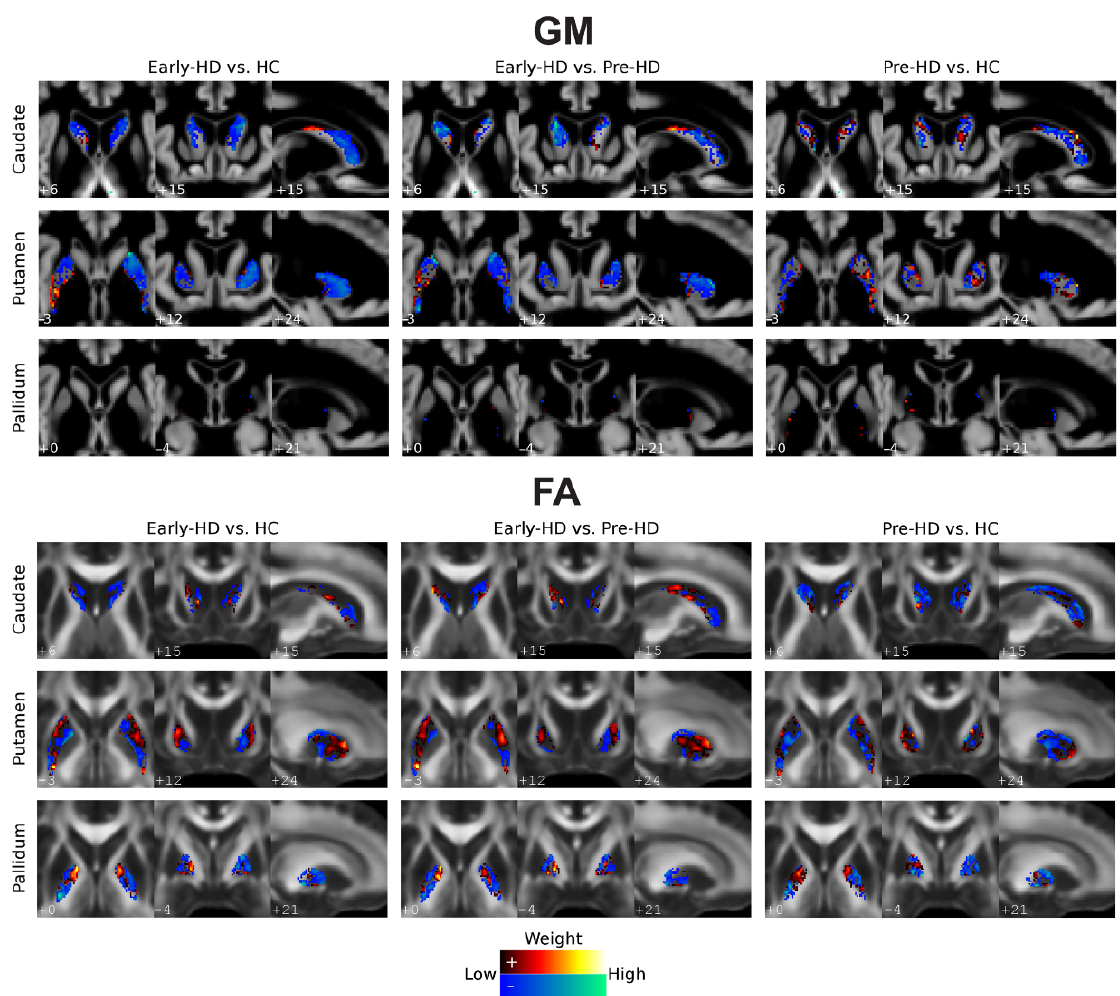
Figure 2. Voxels’ weight maps for binary classifications using subcortical ROIs. Weight maps are depicted for each binary classification (Early-HD vs. Pre-HD, Early-HD vs. HC, and Pre-HD vs. HC) and subcortical ROI (bilateral caudate, putamen, and pallidum, respectively). Axial, coronal, and sagittal views that maximize visualization of each ROI per one slice, respectively, are identified. Top: Classification with GM features. The weight maps are overlaid on a mean GM image, in grey scale, calculated using all study participants; Bottom: Classification with FA features. For visualization, the weights are overlaid on a standard FA image (FMRIB58_FA) to which each participant’s data were co-registered. The hot (red-yellow) and cold (blue-green) color maps show the positive and negative weights, respectively. For visualization purposes, weight values at the lowest 10% range (closer to zero, positive, and negative) are not displayed. The ‘Low’ (closer to zero) and ‘High’ (further away from zero) descriptions refer to absolute weight values.